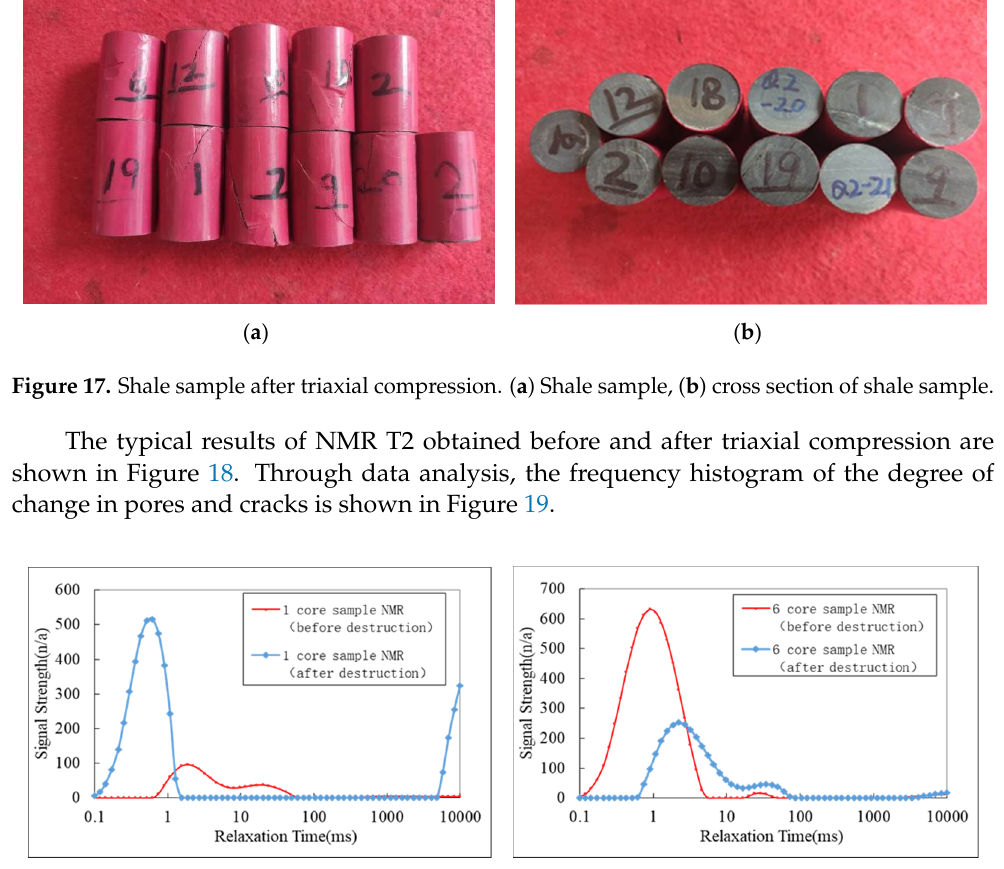
9 of 16 Figure 16. Correlation distribution of radial compression force and elastic index of core. 5. NMR Test and Discussion The measurement of the porosity of the sample mainly uses the one-dimensional steady state Darcy’s law. The rock sample was installed in the core holder to simulate the stress condition of the formation, and nitrogen gas was introduced to measure the gas permeability of the rock sample. The rock sample was placed in a closed saturated con- tainer, vacuumized at − 0.1MPa for more than 5 h, saturated liquid was then put into the rock sample cup in the container, and then continued to vacuum until no bubbles were released. The high-pressure pump was used to simulate the formation pressure which was set for more than 24 h. The weight of the sample after saturation with the liquid and the weight of the sample in the liquid were measured. The porosity and pore volume of the sample were calculated as follows [20,21]: 1